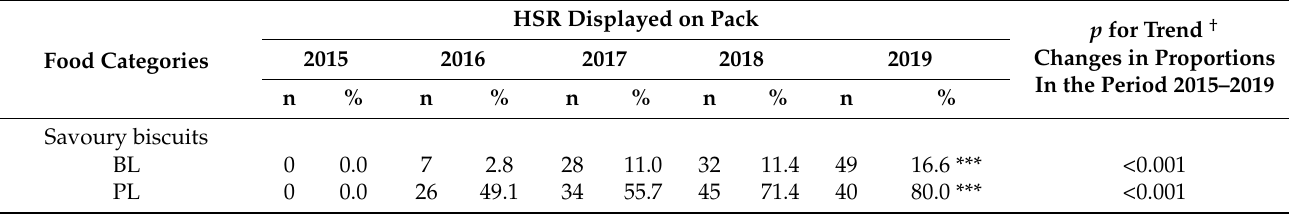
Table 3. Number and proportion of branded and private label products displaying HSR on the pack by year (2015–2019), food category and